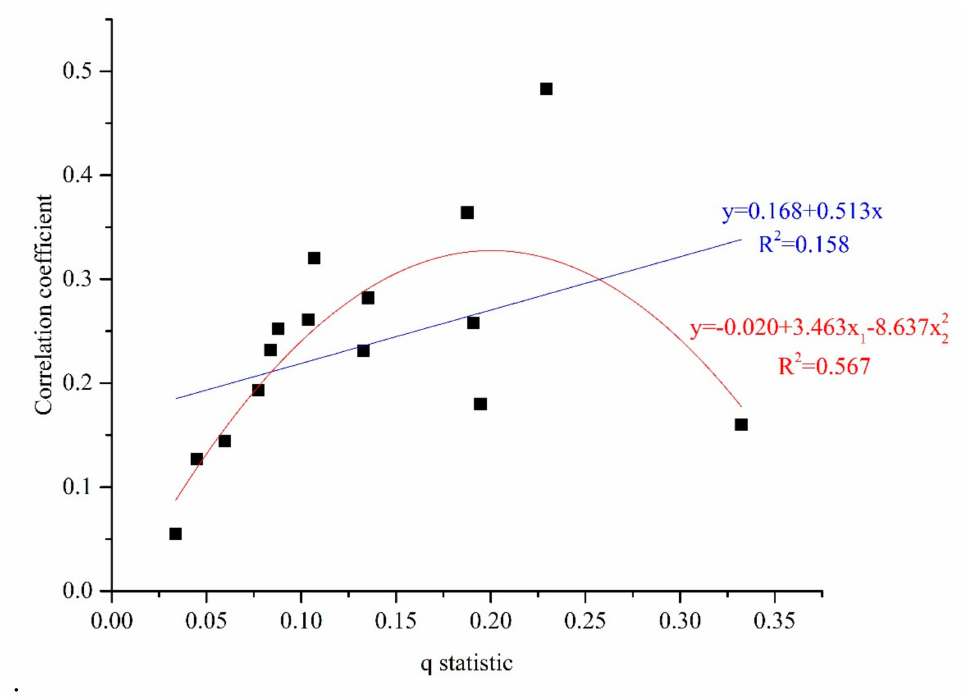
Figure 5. Fitting lines between the q statistic and the correlation